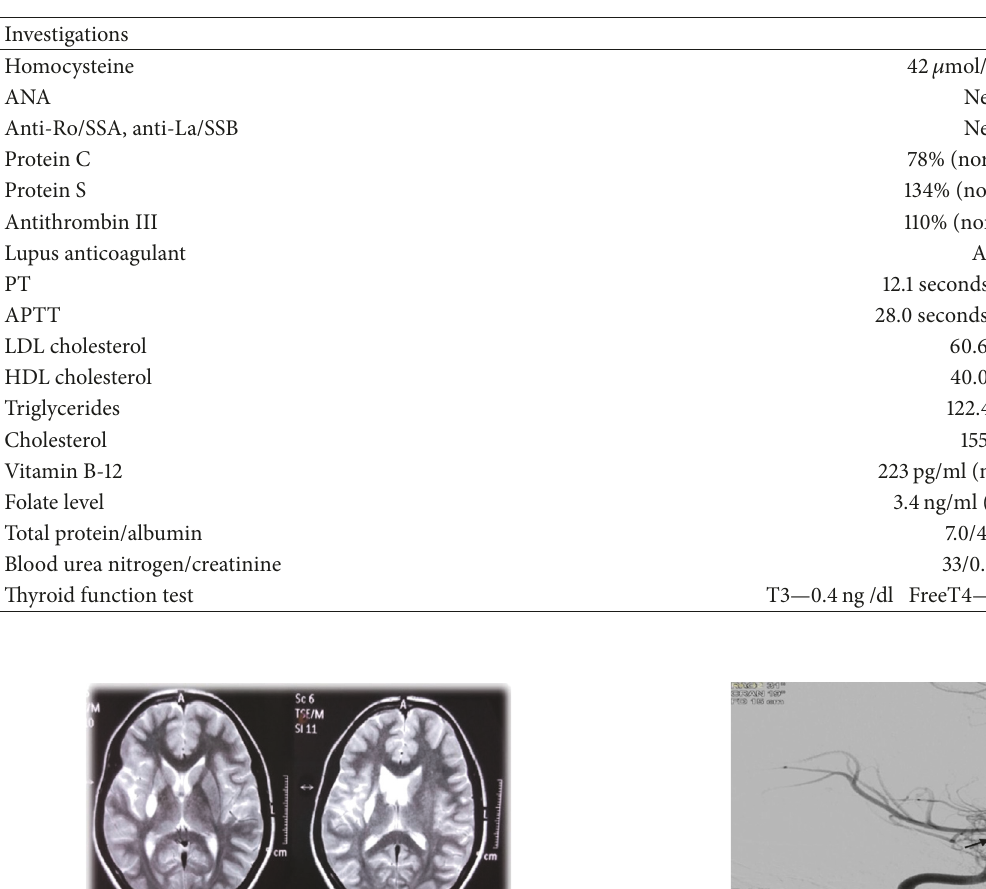
Table 1: Biochemical and haematological investigations.